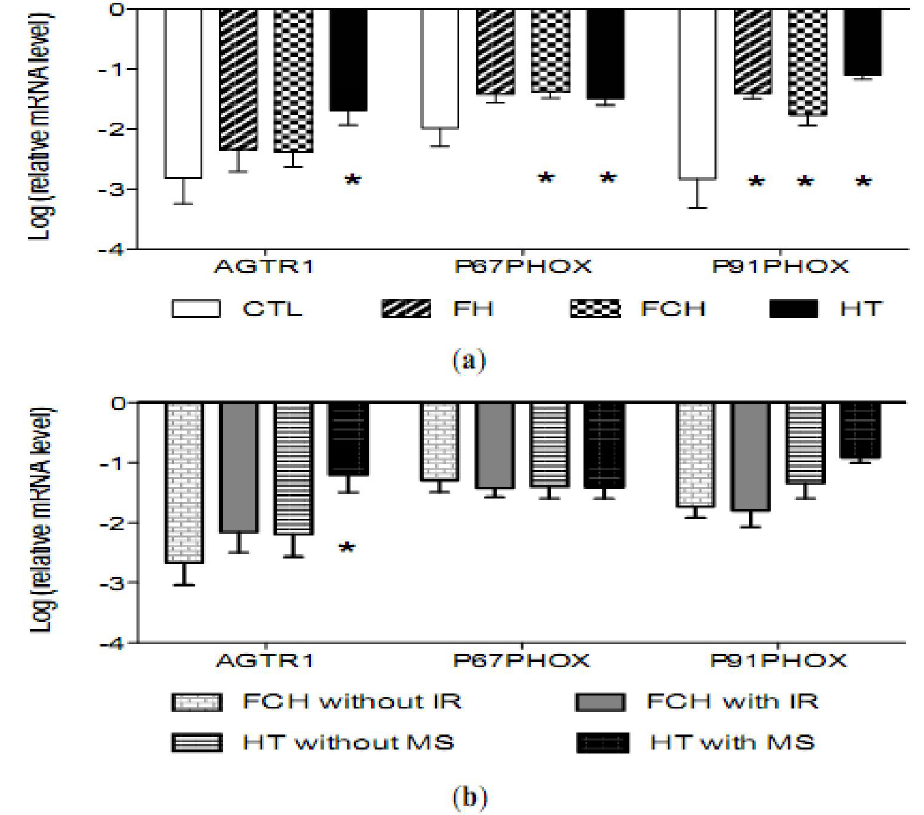
Figure 1. Angiotensin AT1 receptor (AGTR1) and some components of the NADPH oxidase (P91PHOX, P67PHOX) log ratio relative mRNA values in mononuclear cells of ( a ) controls ( n = 20, CTL), familial hypercholesterolemia ( n = 17, FH), familial combined hyperlipidemia ( n = 30, FCH) and hypertensives ( n = 43, HT); and ( b ) FCH without insulin resistance ( n = 13, FCH without IR), FCH with insulin resistance ( n = 17, FCH with IR), HT without metabolic syndrome ( n = 21, HT without MS) and HT with metabolic syndrome ( n = 22, HT with MS) of the study population. * p values denote differences between controls and disease. Statistical tests: Multivariate linear regression analyses adjusted by age, gender and BMI. NOTE: A gene is up-regulated when their relative values are higher in the disease group than controls. However, if the values are lower ones, the gene is